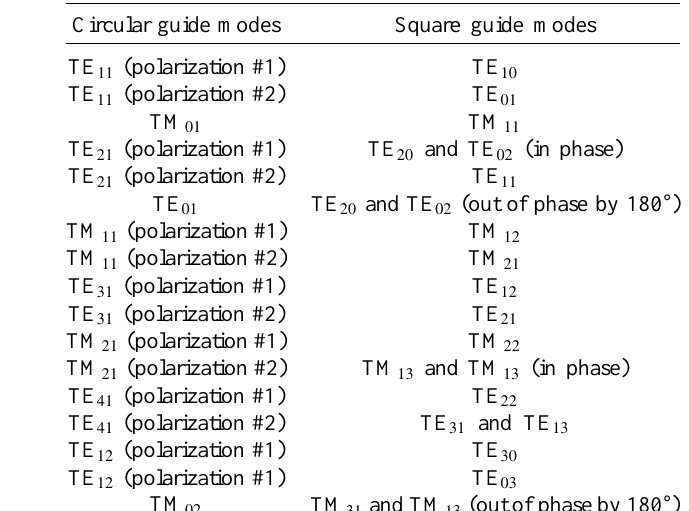
FIG. 6. Rectangular waveguide calibration measurements.